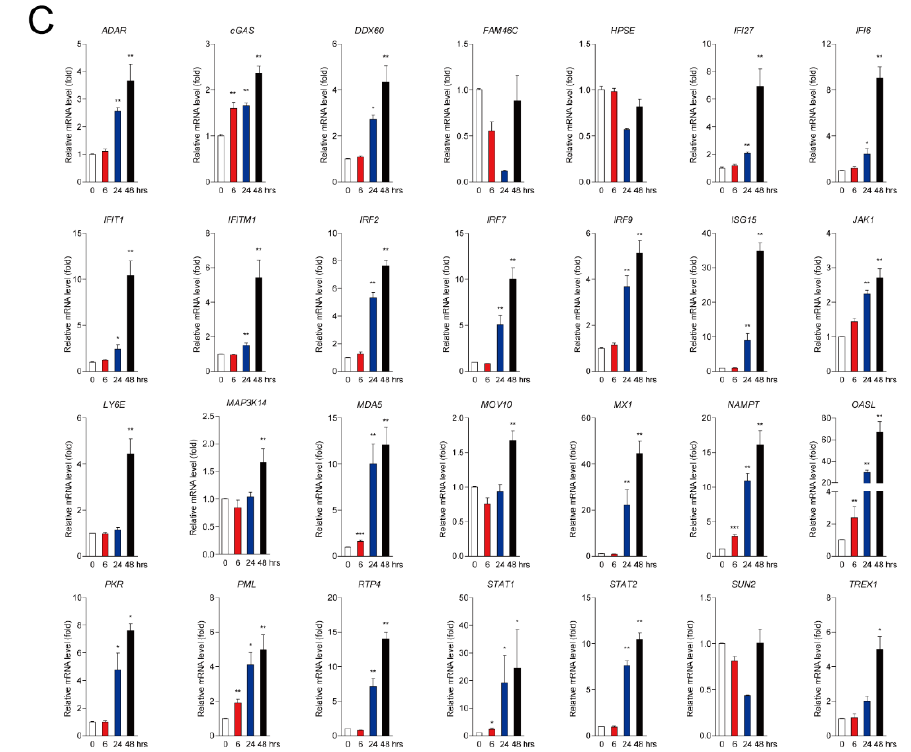
Figure 1. Mtb infection enhances cellular cytokines production and a subset of interferon stimulated genes (ISGs) production in M φ s. ( A ) TNF- α , IL-1 β , IL-6, IL-8, IL-10. and IFN- γ were detected by quantitative real-time-polymerase chain reaction (qRT-PCR) with H37Rv infection (multiplicity of infection (MOI) = 2) for 0 (white bars), 6 (red bars), 24 (blue bars) and 48 (black bars) h in human monocyte-derived M φ s (hMDMs). ( B,C ) Transcript levels of 28 ISGs in hMDM ( B ) and THP-1-M φ s ( C ) upon virulent Mtb strains H37Rv infection (MOI = 2). Data are expressed as mRNA fold change relative to uninfected cells. glyceraldehyde 3-phosphate dehydrogenase (GAPDH) served as an internal reference. (Data presented as mean ± SEM, n = 3 independent experiments each with 2 replicates). Infection time was indicated as 0 (white bars), 6 (red bars), 24 (blue bars) and 48 (black bars) h. * p < 0.05 and ** p < 0.01 were considered as GAPDH statistically